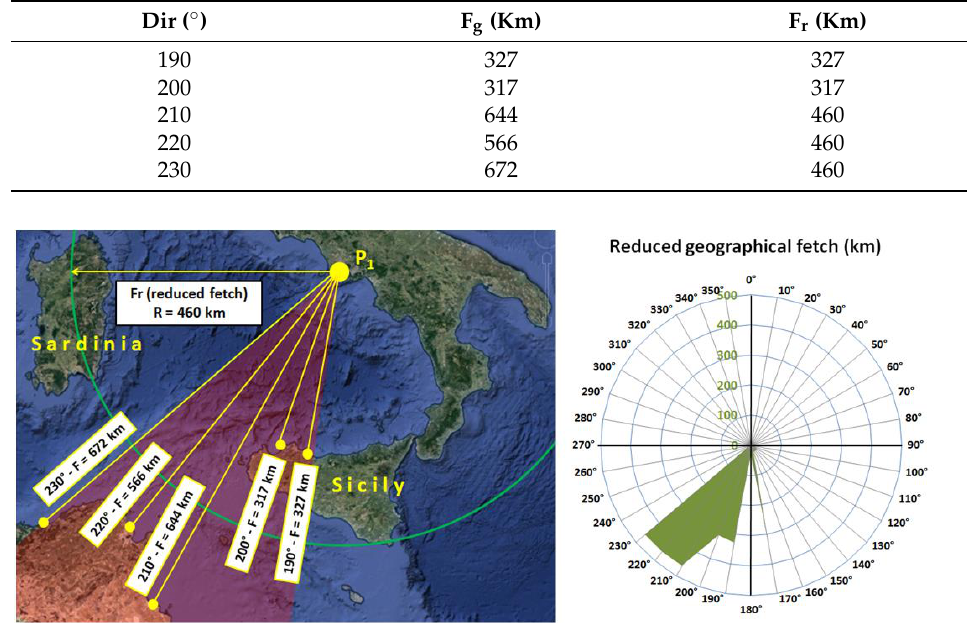
Figure 11. Map and diagram of fetch relative to P 1 in Figure 10. Map highlights the reduction of fetch in the main wave exposure through the green circle.